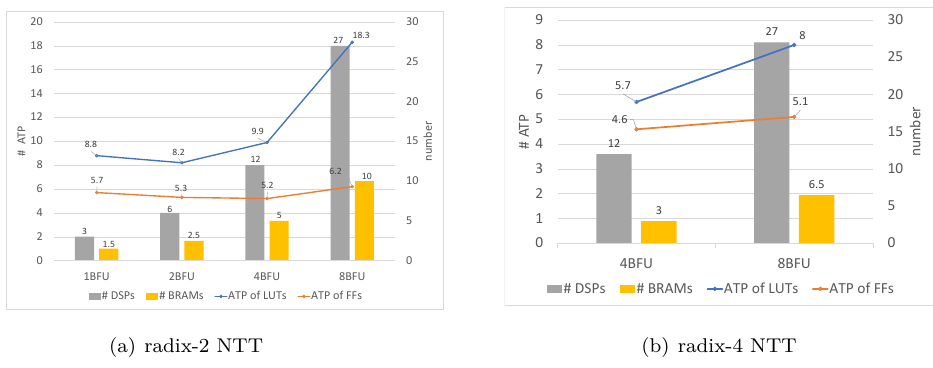
Figure 12: The variation of ATP in radix-2 and radix-4 NTT (N = 1024, 14-bit q). the same number of butterfly units. This advantage is enlarged with the growth of parallel degree. When setting the number of butterfly units to 8, the ATP of LUT/FF in radix-4 NTT core is approximately 2 . 2 × / 1 . 2 × less than the radix-2 NTT core. Moreover, the radix-4 NTT configured with 4 butterfly units achieves the best balance between area and time among these designs. The right coordinate indicates how the number of DSP and BRAM varies with the parallel degree. Since the radix-2 and radix-4 butterfly unit consume the same number of modular multiplication, the growth of DSP is identical as well. But the radix-4 NTT consumes less number of BRAMs. Table 4 in Appendix also presents the detailed resource usage broken down across different modules for radix-2 and radix-4 NTT cores with different number of parallel butterfly units. This table is made according to the resource utilization reported by Vivado 2020.2 on Windows 10. Table 2: Conflict-free memory mapping scheme comparisons with related work.